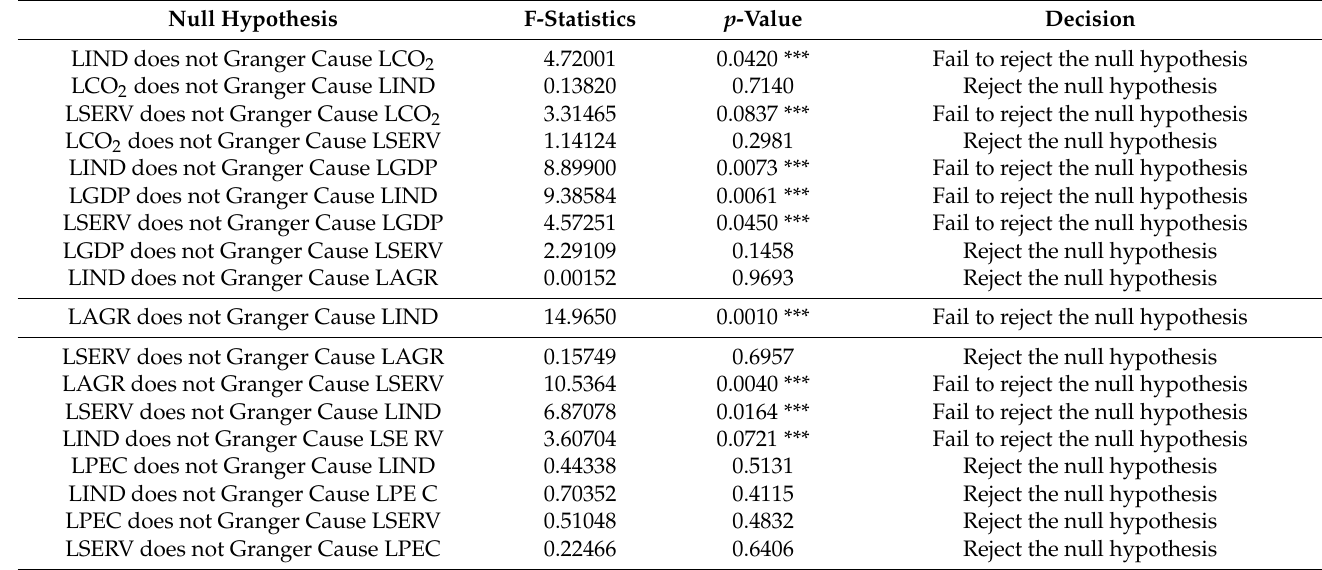
Table A6. Pairwise Granger causality